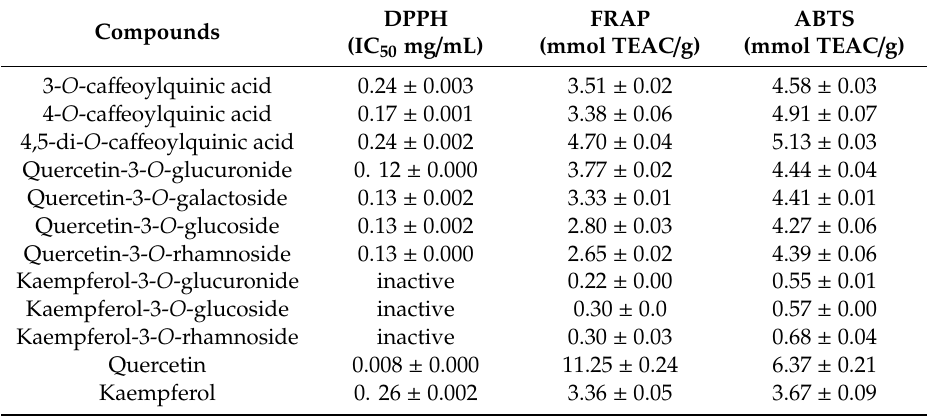
Table 2. The antioxidant performances of di ff erent phenolic compounds in C. paliurus